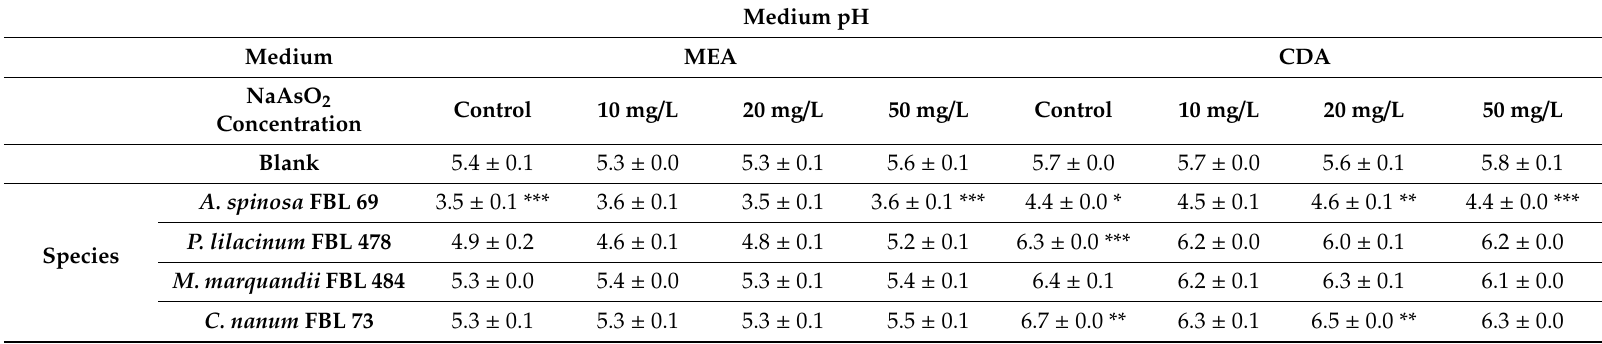
Table 4. pH values of the medium after growth of the fungal species for seven days at 25 ◦ C. Data are expressed as the mean ± standard error of independent biological replicates a